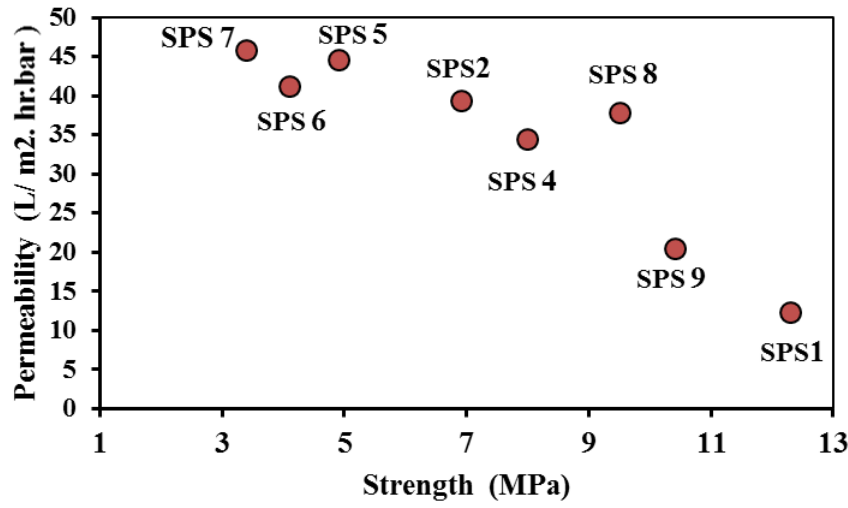
Figure 10. Permeability and strength of alumina–CNT membranes produced under different SPS process conditions.